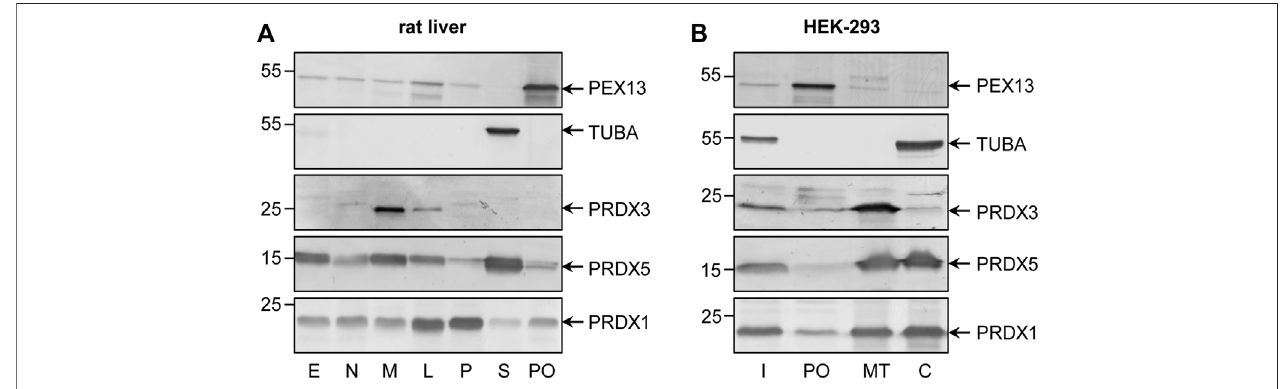
FIGURE6| SubcellulardistributionofPRDX1inratliverandHEK-293cells. (A) Ratliverprotein(20 µg)presentinapost-nuclearfraction(E),anuclearfraction(N),a heavy mitochondrial fraction (M), a light mitochondrial fraction (L), a microsomal fraction (P), the cytosol (S), or puri fi ed peroxisomes (PO) were subjected to SDS-PAGE and processed for immunoblotting with antibodies directed against PEX13 (peroxisomes), TUBA (cytosol), PRDX3 (mitochondria), PRDX5 (cytosol, mitochondria, nucleus, and peroxisomes), or PRDX1. (B) Total cell homogenates from Flp-In T-REx 293 cells were fractionated by differential centrifugation to yield a 1,500 x g supernatant (Input, (I)) that was subsequently subjected to Nycodenz gradient centrifugation (Lismont et al., 2019c). The I fraction (8% of the amount loaded onto the gradient) and equal volumes of gradient fractions enriched in peroxisomes (PO), mitochondria (MT), or the cytosol (C) were processed for immunoblot analysis as described for the rat liver fractions. The migration points of relevant molecular mass markers (expressed in kDa) are shown on the left. Speci fi c proteins are marked by arrows.